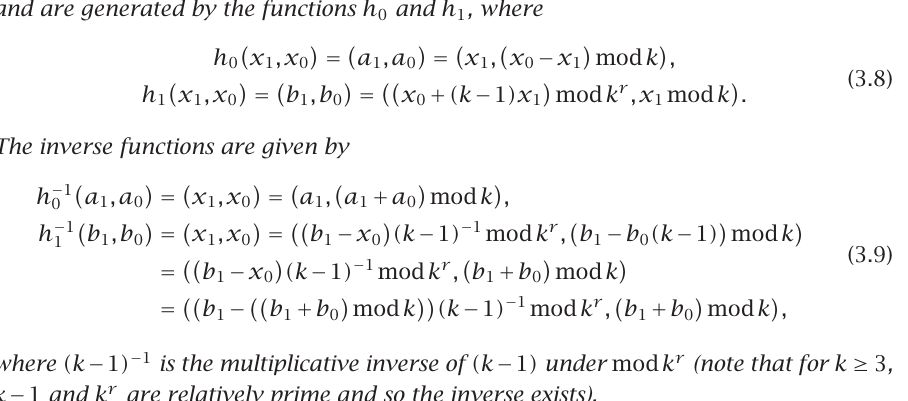
9 , 3 produced by